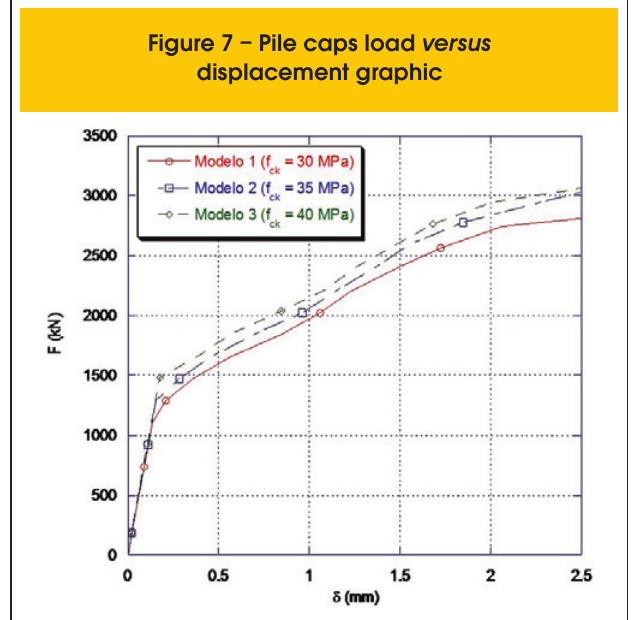
Figure 7 – Pile caps load versus displacement